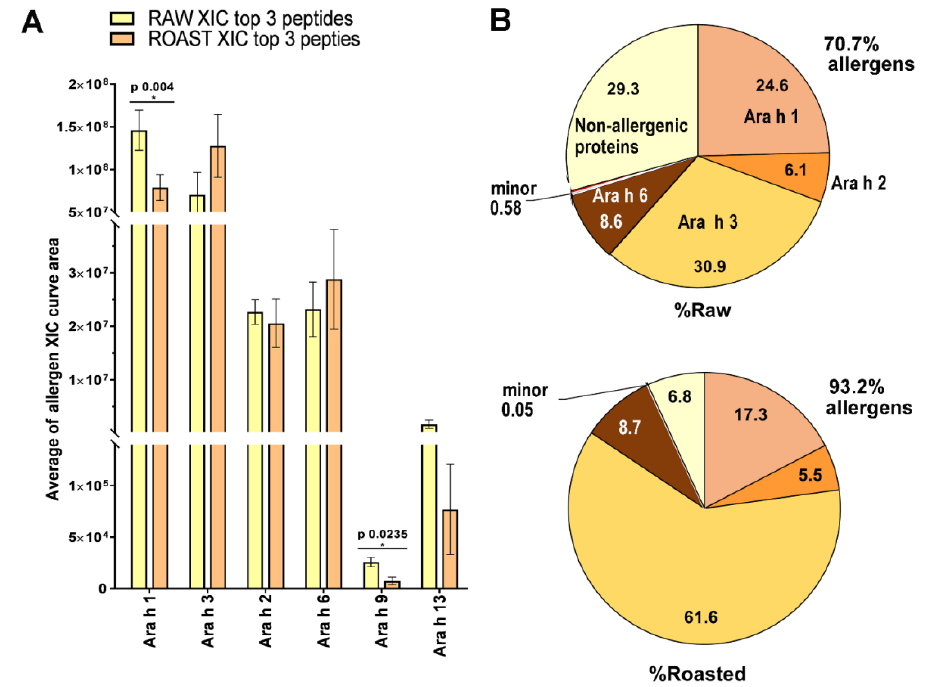
Figure 1. Raw and roasted PBS-based peanut extract protein profiles were calculated from Report S2, supplementary material [18]. ( A ) Label-free quantification of raw and roasted peanut allergens determined using PEAKS X Pro Studio (two groups, each with biological triplicates). Two tail, unpaired Student t-test was used to search for significant differences among XIC averages at p < 0.05. *—denotes significant difference in respect to raw peanut control sample. XIC—extracted ion chromatogram. ( B ) Relative abundance of allergens and non-allergenic proteins. The sum of the areas under the XIC curves for a given allergen was expressed as a percentage of the total (sum of all proteins identified in raw or roasted peanut